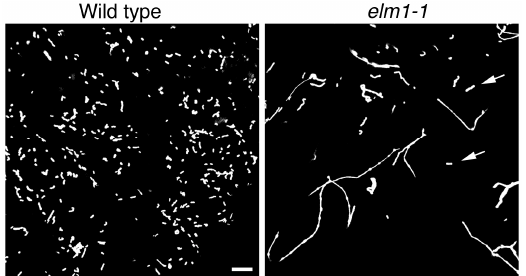
Figure 1. Mitochondrial morphologies in wild-type Arabidopsis and the elm1-1 mutant. The images show GFP-labeled mitochondria in leaf epidermal cells. Mitochondria in the elm1-1 mutant are longer and fewer than those in the wild type, because of the disturbance of mitochondrial fission in the